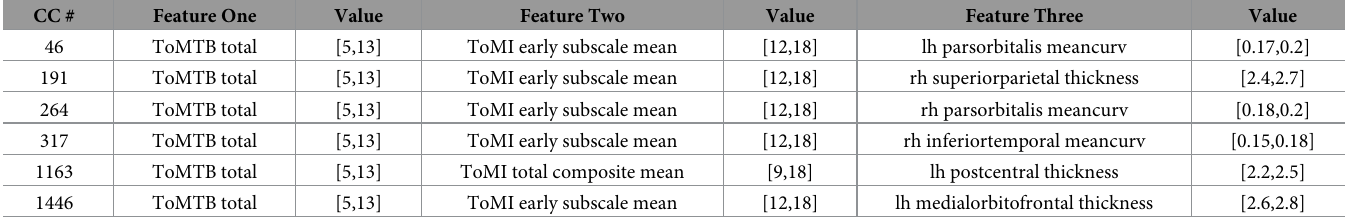
Table 4. Third-order CC model features and range of